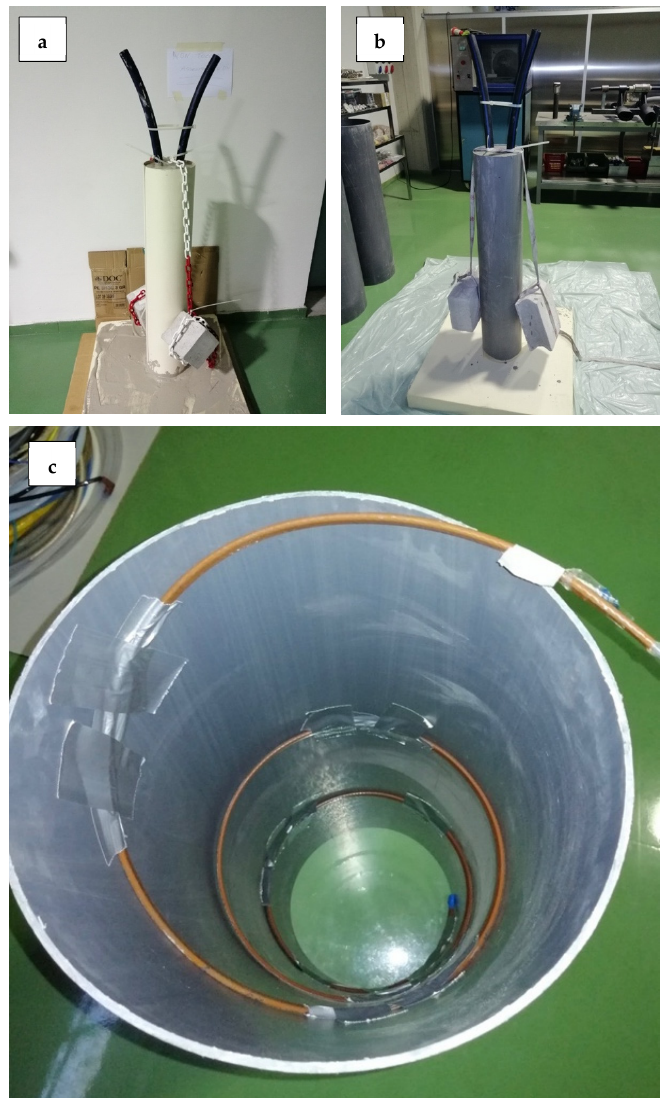
Figure 4. ( a ) Preparation of the standard system for the thermal response test; ( b ) preparation of the innovative system for the thermal response test; and ( c ) heating cable configuration.